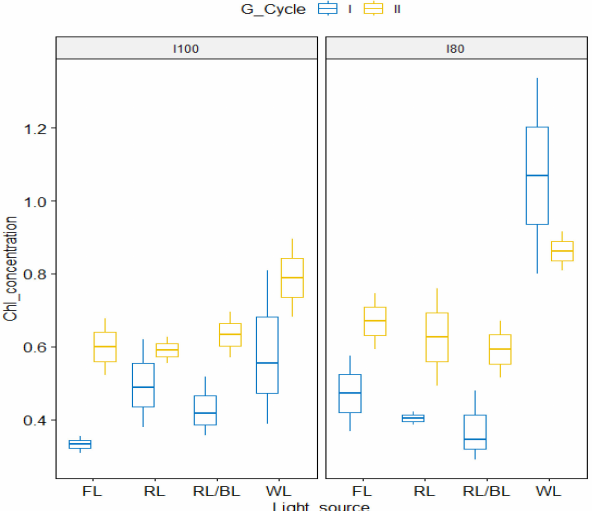
Figure 4. Box plot of chlorophyll concentration in the two growing cycles as influenced by light spectra in relation to 100 µ mol m − 2 s − 1 ( left panel) and the 80 µ mol m − 2 s − 1 ( right panel) lower light intensity.